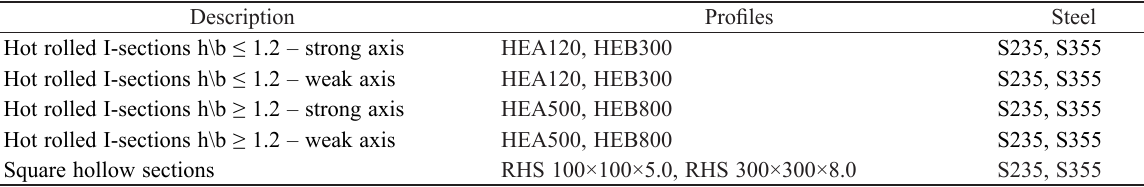
Table 1. Modelling